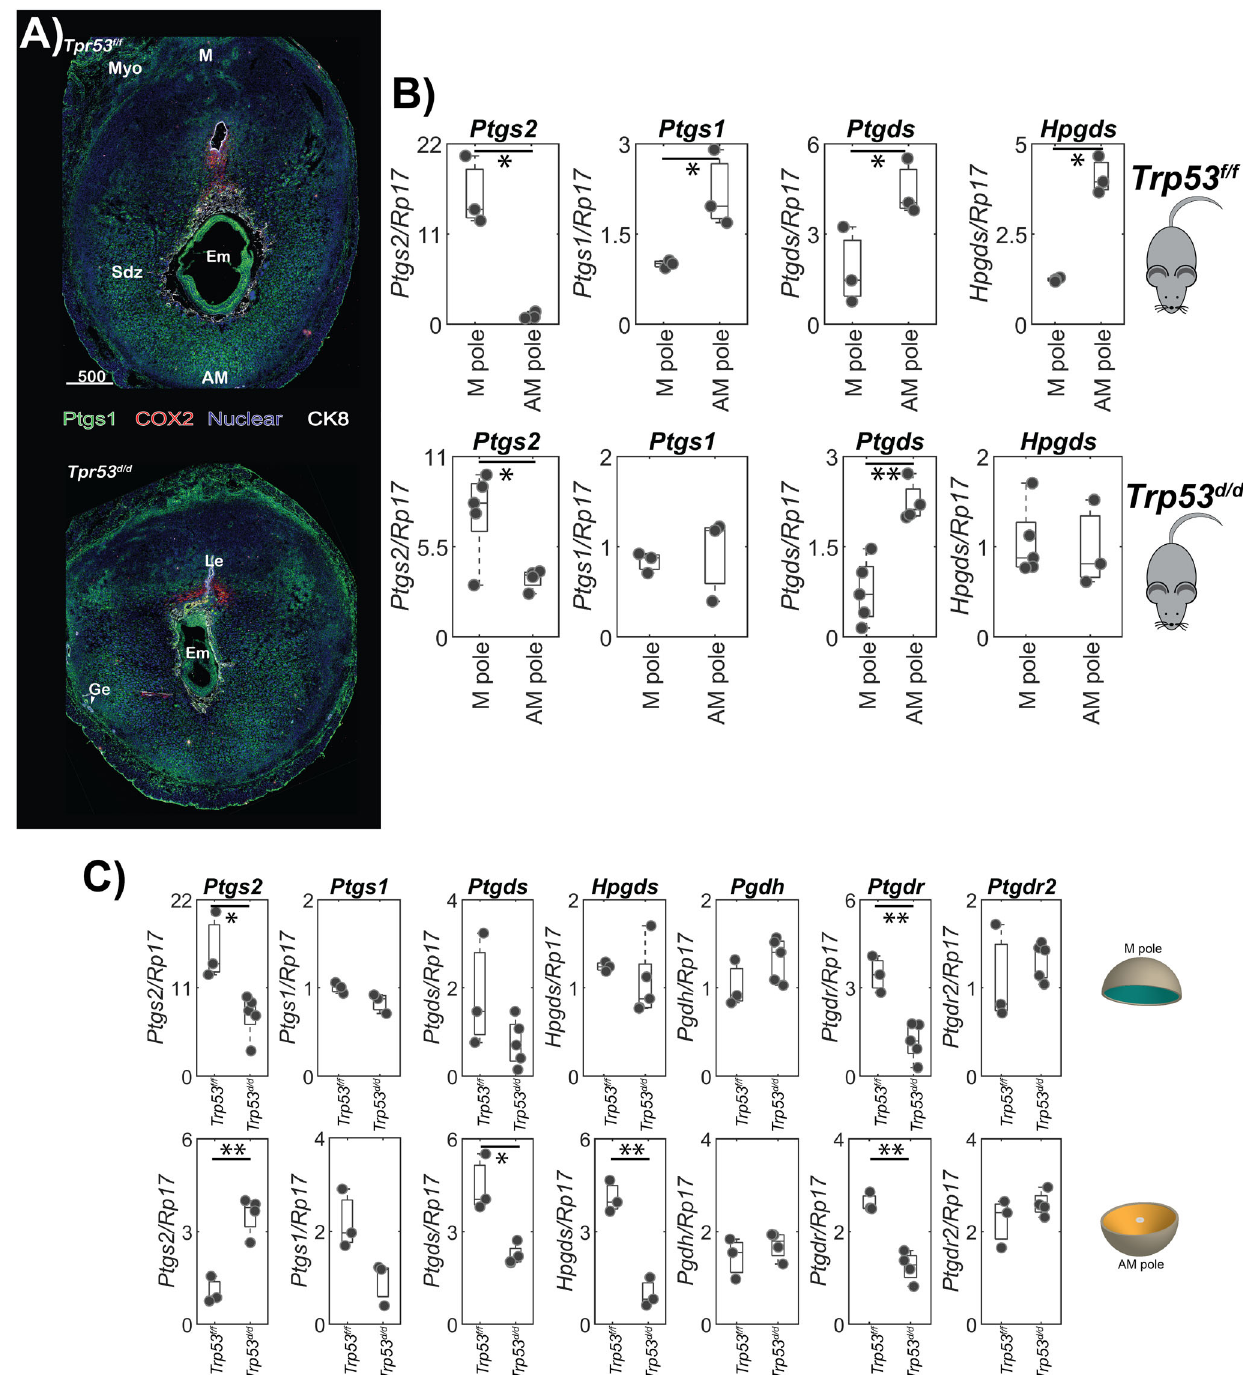
Fig. 3 Distribution of proteins involved in PG synthesis, hydrolysis, and signaling in implantation sites on day 8 of pregnancy. A Fluorescence in situ hybridization of Ptgs1 and COX2 in Trp53 f/f and Trp53 d/d implantation sites on day 8 of pregnancy. The embryonic trophoblasts are outlined by Cytokeratin 8 (CK8) immunostaining. M mesometrial pole; AM anti-mesometrial pole; Em embryo; SDZ secondary decidual zone; Myo myometrium; scale bar, 500 µ m. B Segmented RT-qPCR results for Ptgs2 , Ptgs1 , Ptgds , Hpgds , in the AM and M-poles in Trp53 f/f and Trp53 d/d implantation sites on day 8 of pregnancy. C Segmented RT-qPCR results showing the expression of Ptgs2 , Ptgs1 , Ptgds and Hpgds, Pgdh, Ptgdr, and Ptgdr2 in the M-pole and AM-pole of the implantation sites comparing the Trp53 f/f and Trp53 d/d implantation sites. Signi fi cance is determined by a two-tailed student ’ s t -test, where * p -value < 0.05, ** p -value < 0.01, *** p -value < 0.001.